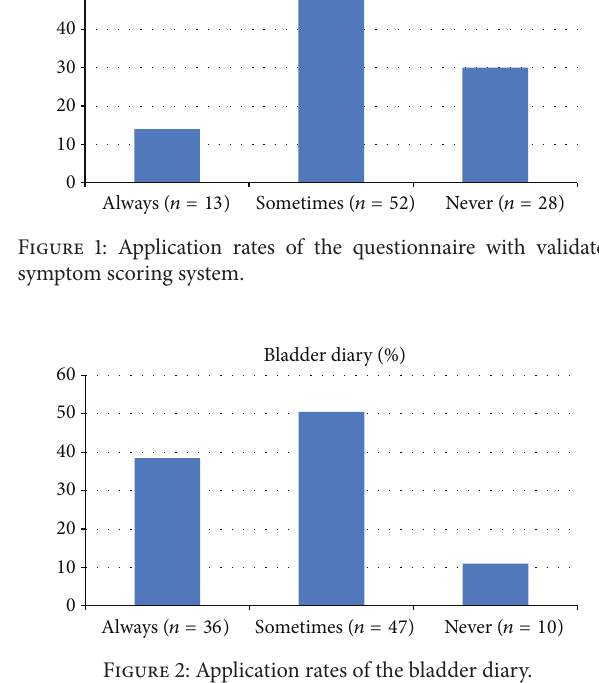
Figure 2: Application rates of the bladder diary.